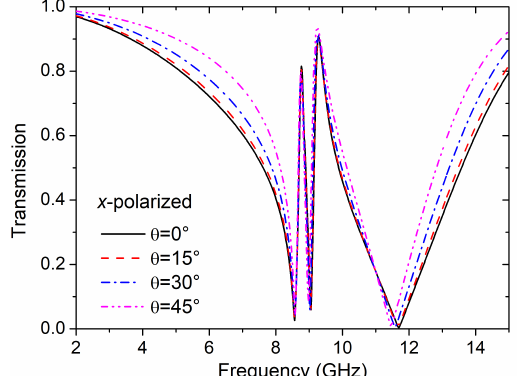
Figure 7: Transmission spectra of the proposed dual-band polarization independent EIT-like metamaterial for oblique angle of incidences under x -polarized